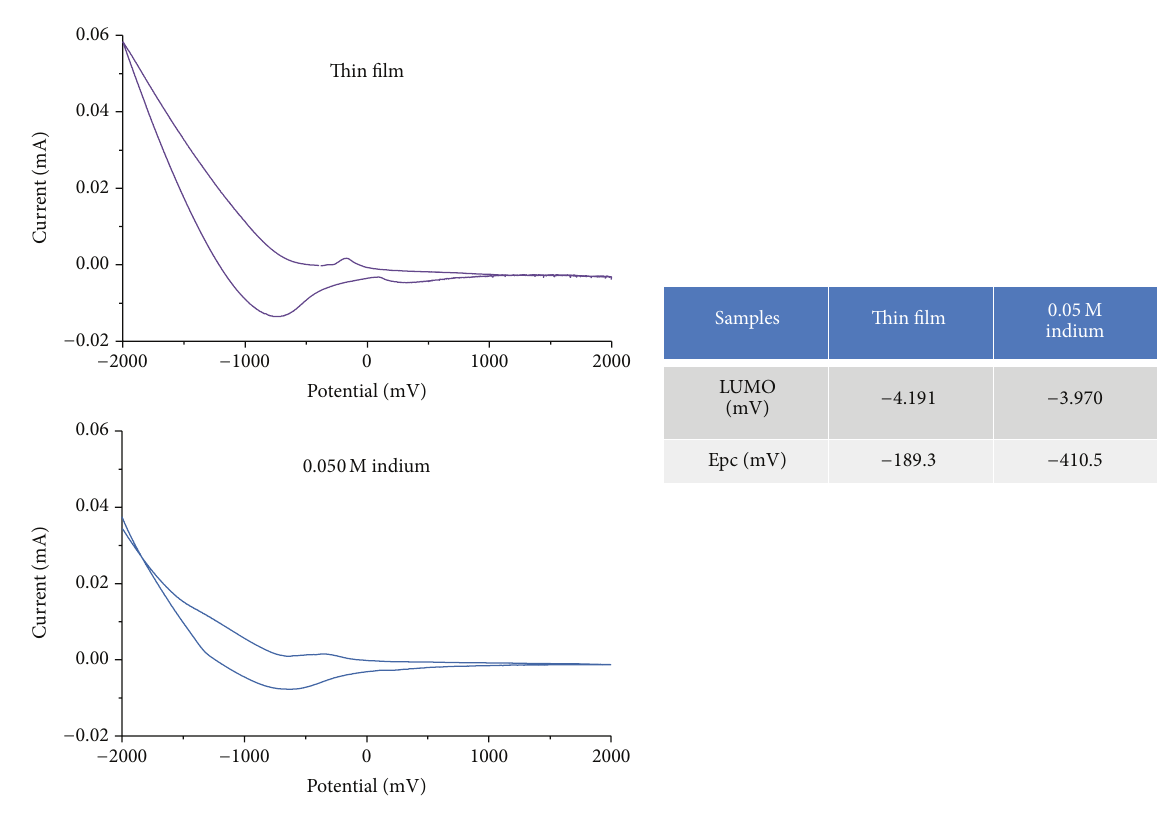
Figure 6: Cyclic voltammetry measurements of the TiO 2 and In 2 S 3